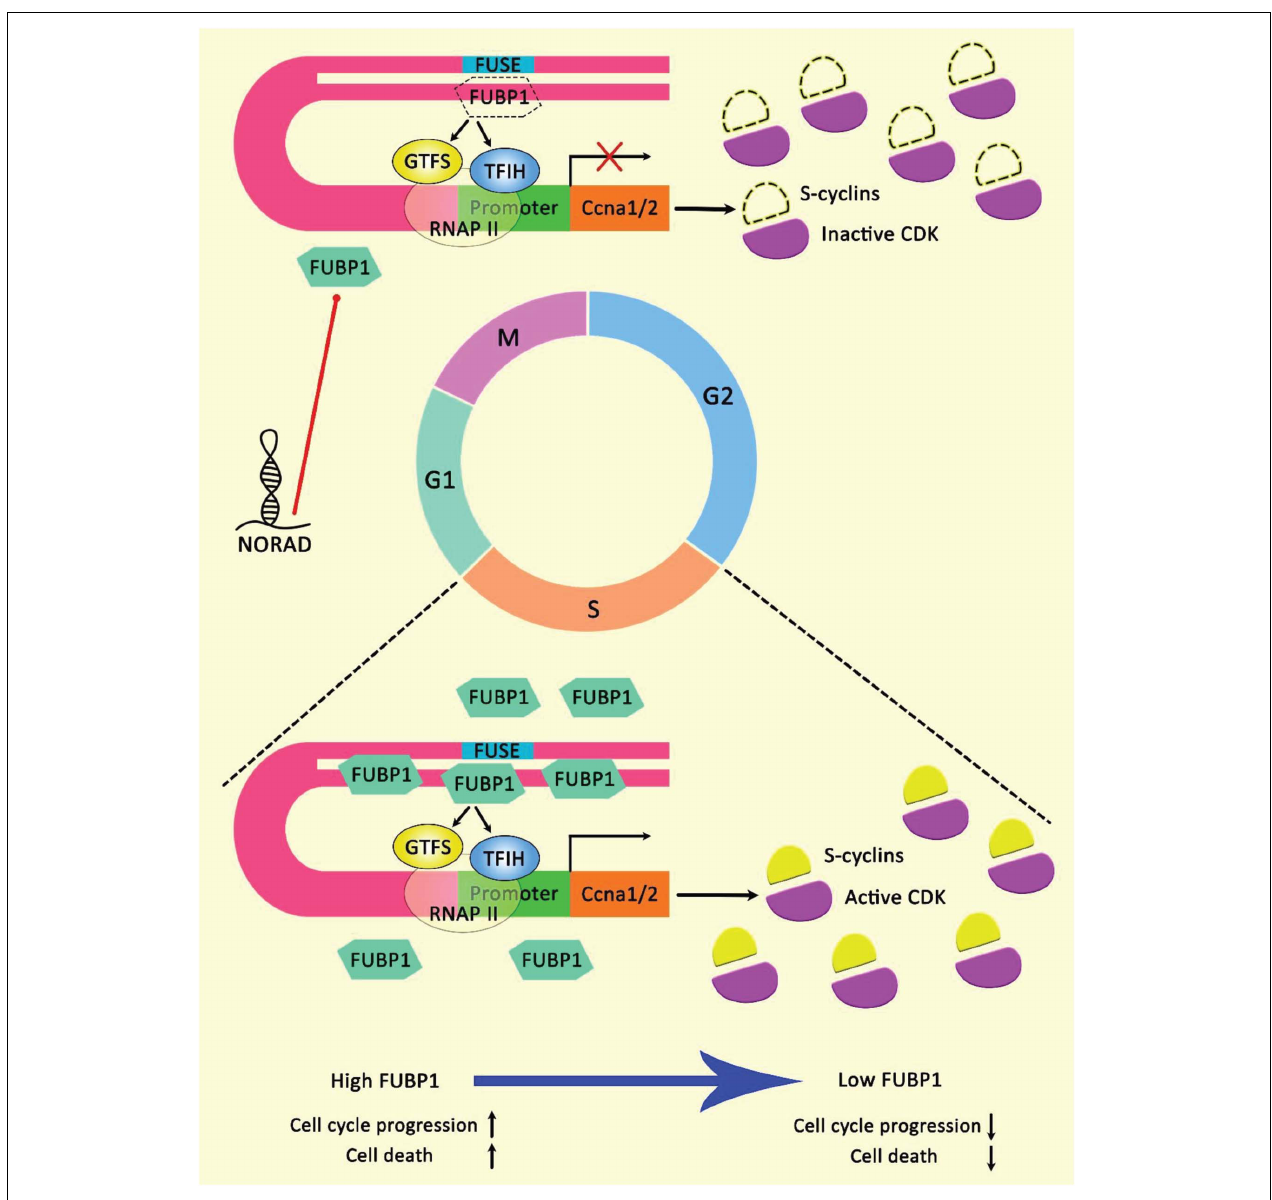
FIGURE 4 | A schematic illustration of the interaction of lncRNA NORAD and FUBP1 in endometrial cancer. FUBP1 is a master transcriptional regulator of various genes via interacting with FUSE. FUBP1 protein level is upregulated in the S phase. Reducing in the expression level of FUBP1 could affect cell cycle progression, particularly in the S phase, via downregulating Ccna gene theat encodes cyclin A. Fubp1-cyclin A axis could play a crucial role in triggering various types of cancers. Heterogeneous expression patterns of Fubp1 could be seen among several cancer tissues, illustrating its multiple and sophisticated functions in